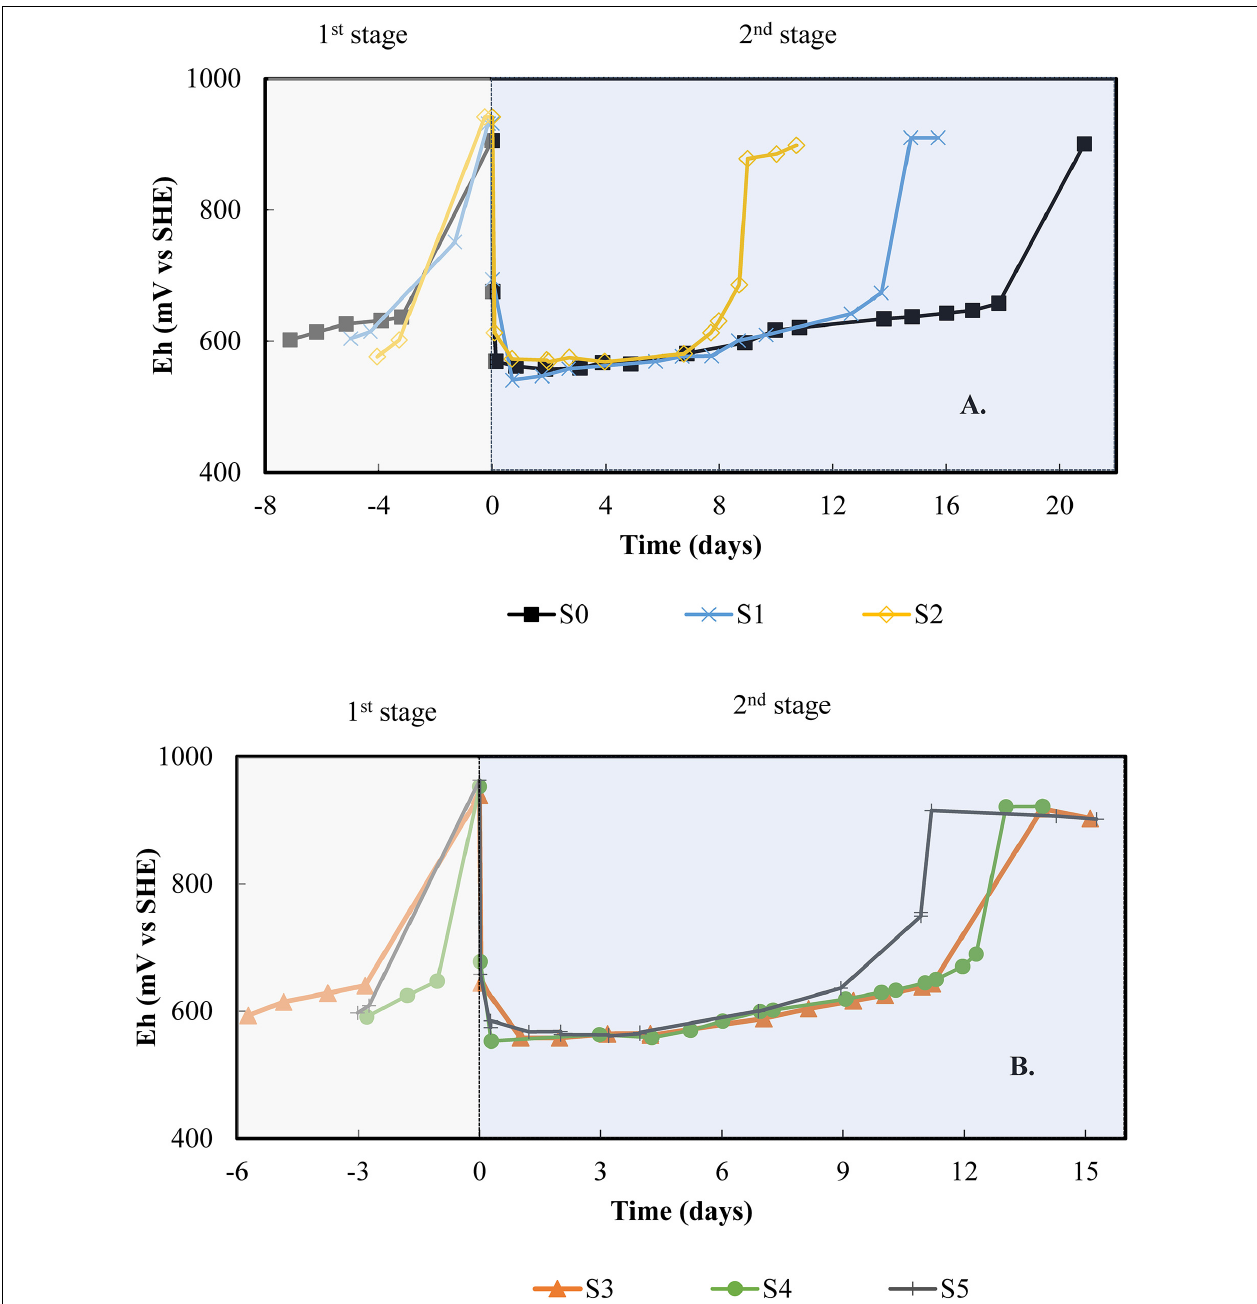
FIGURE 3 | Follow up of redox potential in bioleaching batch subcultures in 2.2 L-STRs: (A) subcultures SO, SI, and S2, (B) subcultures S3, S4, and S5. The first stage involves the microbial oxidation of the 3 Cm medium while the second stage starts with the addition of 2% (w/v)